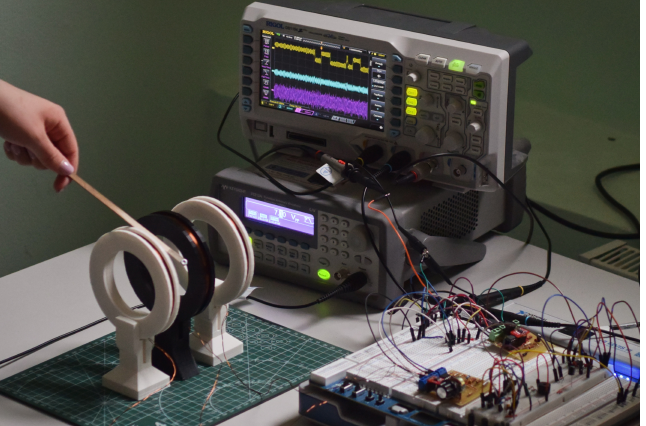
Figure A2. Detection of M2.5 steel washer with 5 mm outer diameter and 0.5 mm thickness. The washer in mounter on a wooden holder, and may be detected if placed in between coils winding; distance between coils is 40